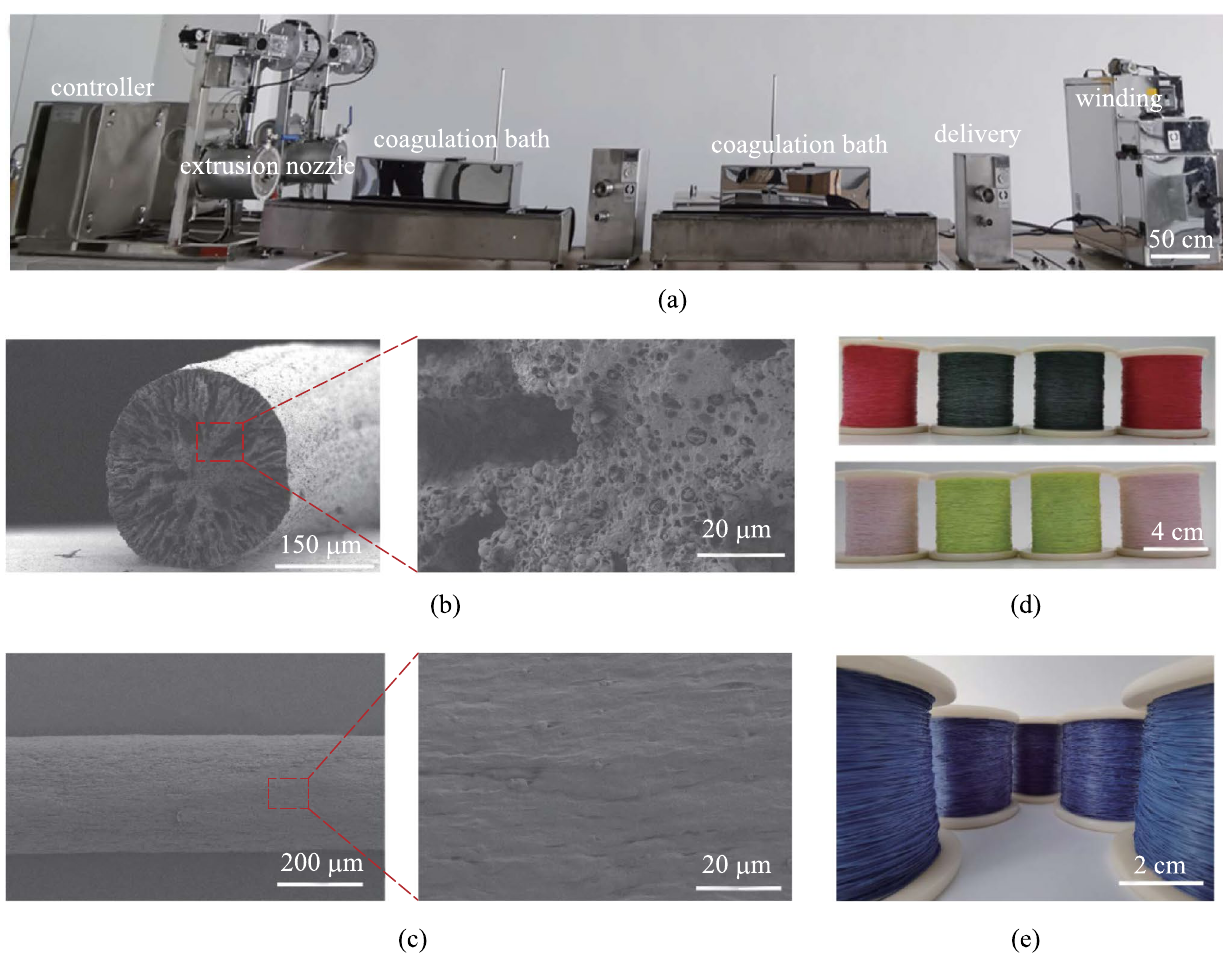
Fig. 1 Fabrication and struction characterization of thermochromic fibers. a Continuous spinning device used to produce thermochromic fibers. b SEM images of cross section of thermochromic fibers. c SEM images of surface morphology of thermochromic microcapsules. d Photograph of thermochromic fibers with multi-color. e Large-scale production of thermochromic